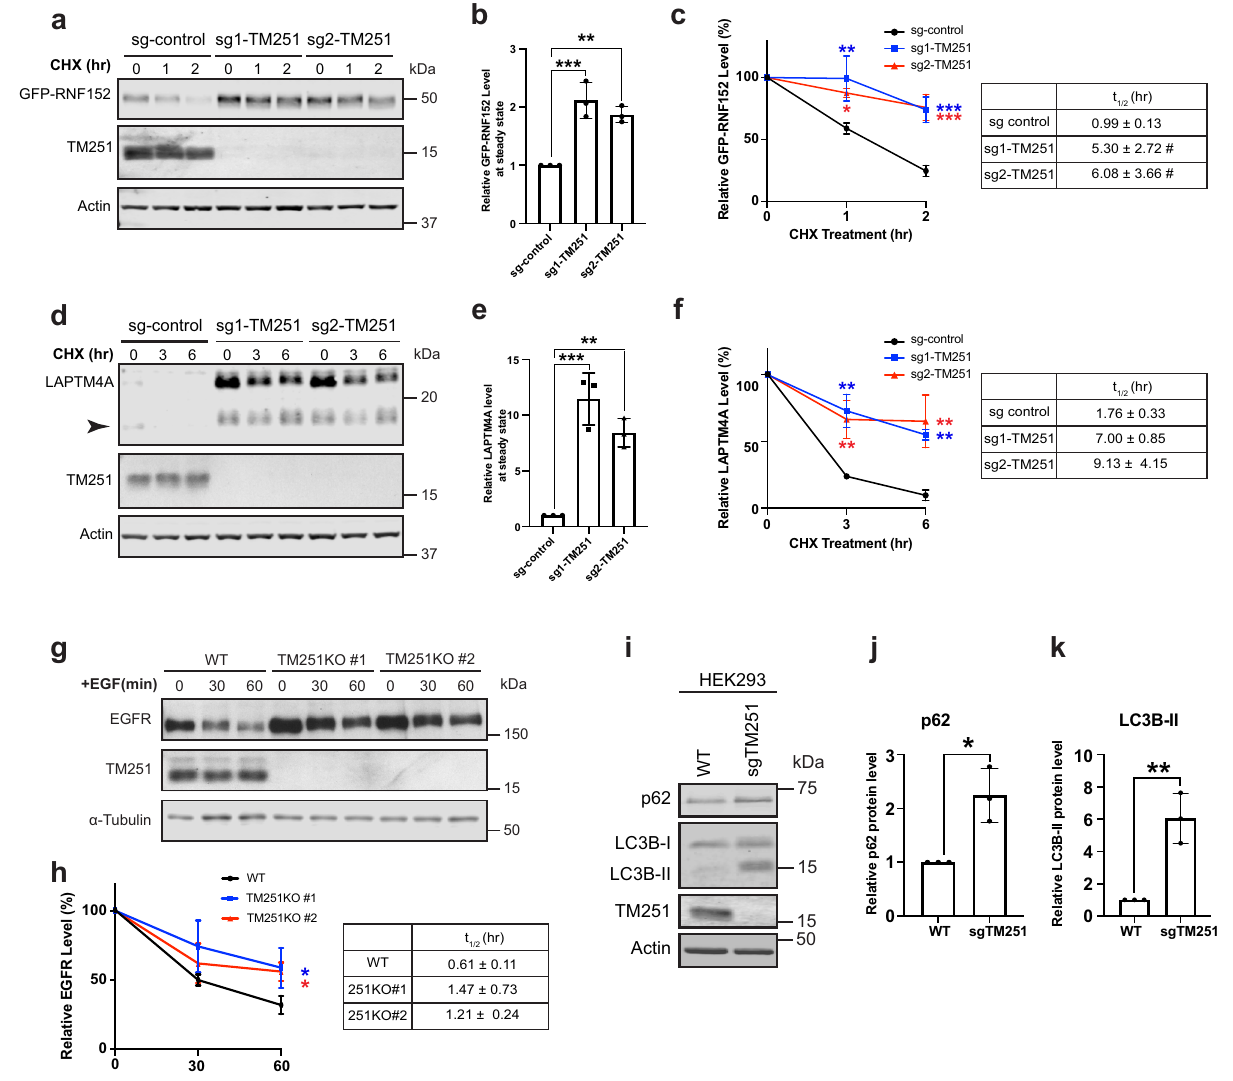
Fig.2|TMEM251de fi ciencyleadstolysosomedysfunction.a CHXchaseassayof stably expressed GFP-RNF152 in sgRNA control, sgRNA-1 TMEM251, and sgRNA-2 TMEM251 cells. b Steady-state (0h) protein levels in a . Mean of 3 independent replicatesisshown.Errorbarsrepresentstandarddeviation.** p ≤ 0.01,*** p ≤ 0.001. c Quanti fi cationofGFP-RNF152degradationin a .Meanof3independentreplicates isshown.Errorbarsrepresentstandarddeviation.* p ≤ 0.05,** p ≤ 0.01,*** p ≤ 0.001. Table:Calculatedproteinhalf-lives. d CHXchaseassayofendogenousLAPTM4Ain sgRNA control, sgRNA-1 TMEM251, and sgRNA-2 TMEM251 cells. Arrowhead: clea- vage productofLAPTM4A. e Steady-state(0h) LAPTM4Aprotein levels in d . Mean of 3 independent replicates is shown. Error bars represent standard deviation.